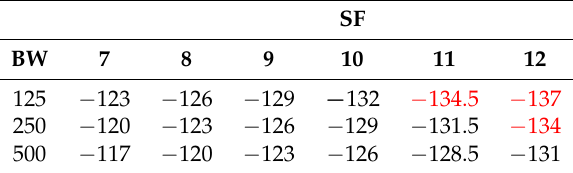
Table 7. Receiver sensitivity in dB. The red color indicates values of the table that are not feasible. SF BW 7 8 9 10 11 12 125 − 123 − 126 − 129 − 132 − 134.5 − 137 250 − 120 − 123 − 126 − 129 − 131.5 500 − 117 − 120 − 123 − 126 − 128.5 − 131